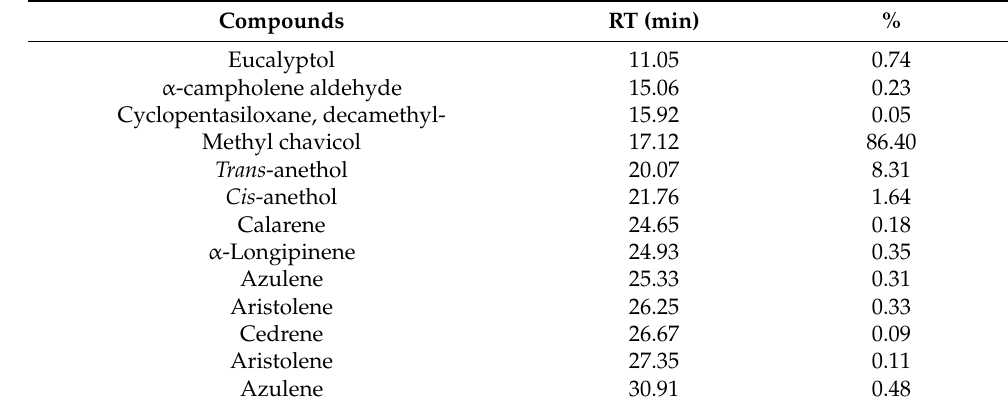
Figure 1. Gas chromatograph of OBEO. Table 1. Chemical composition of OBEO.